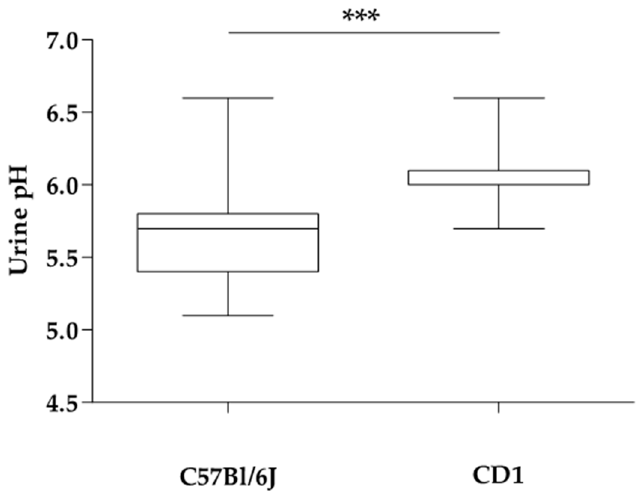
Figure 1. Basal urine pH of the C57Bl/6J inbred strain and the CD1 outbred stock (5.7 ± 0.3 vs. 6.0 ± 0.2; *** p < 0.001).